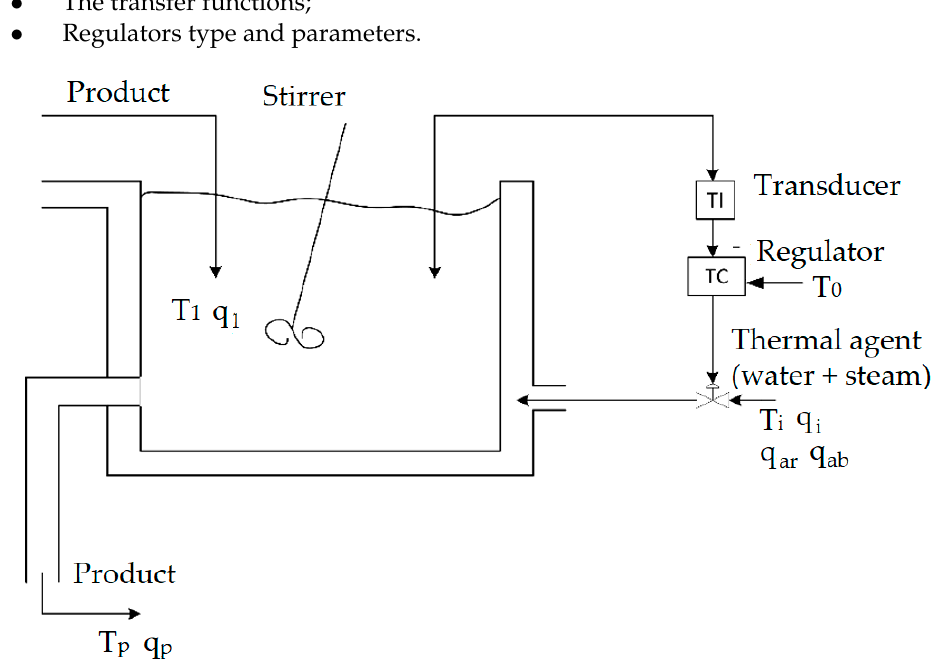
Figure 2. Schematic of the temperature control system.